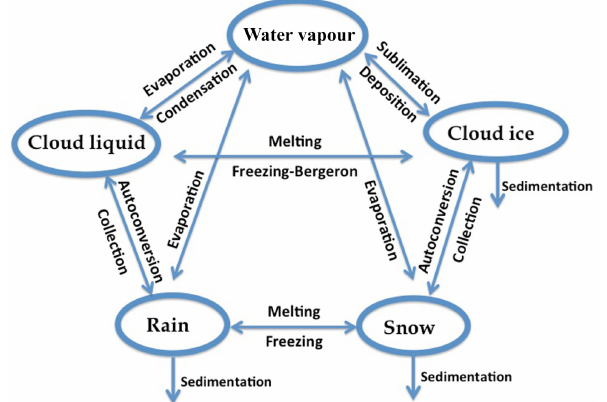
Figure 1. Sketch of the new scheme, showing the five prognostic variables and how they are related to each other through microphys- ical